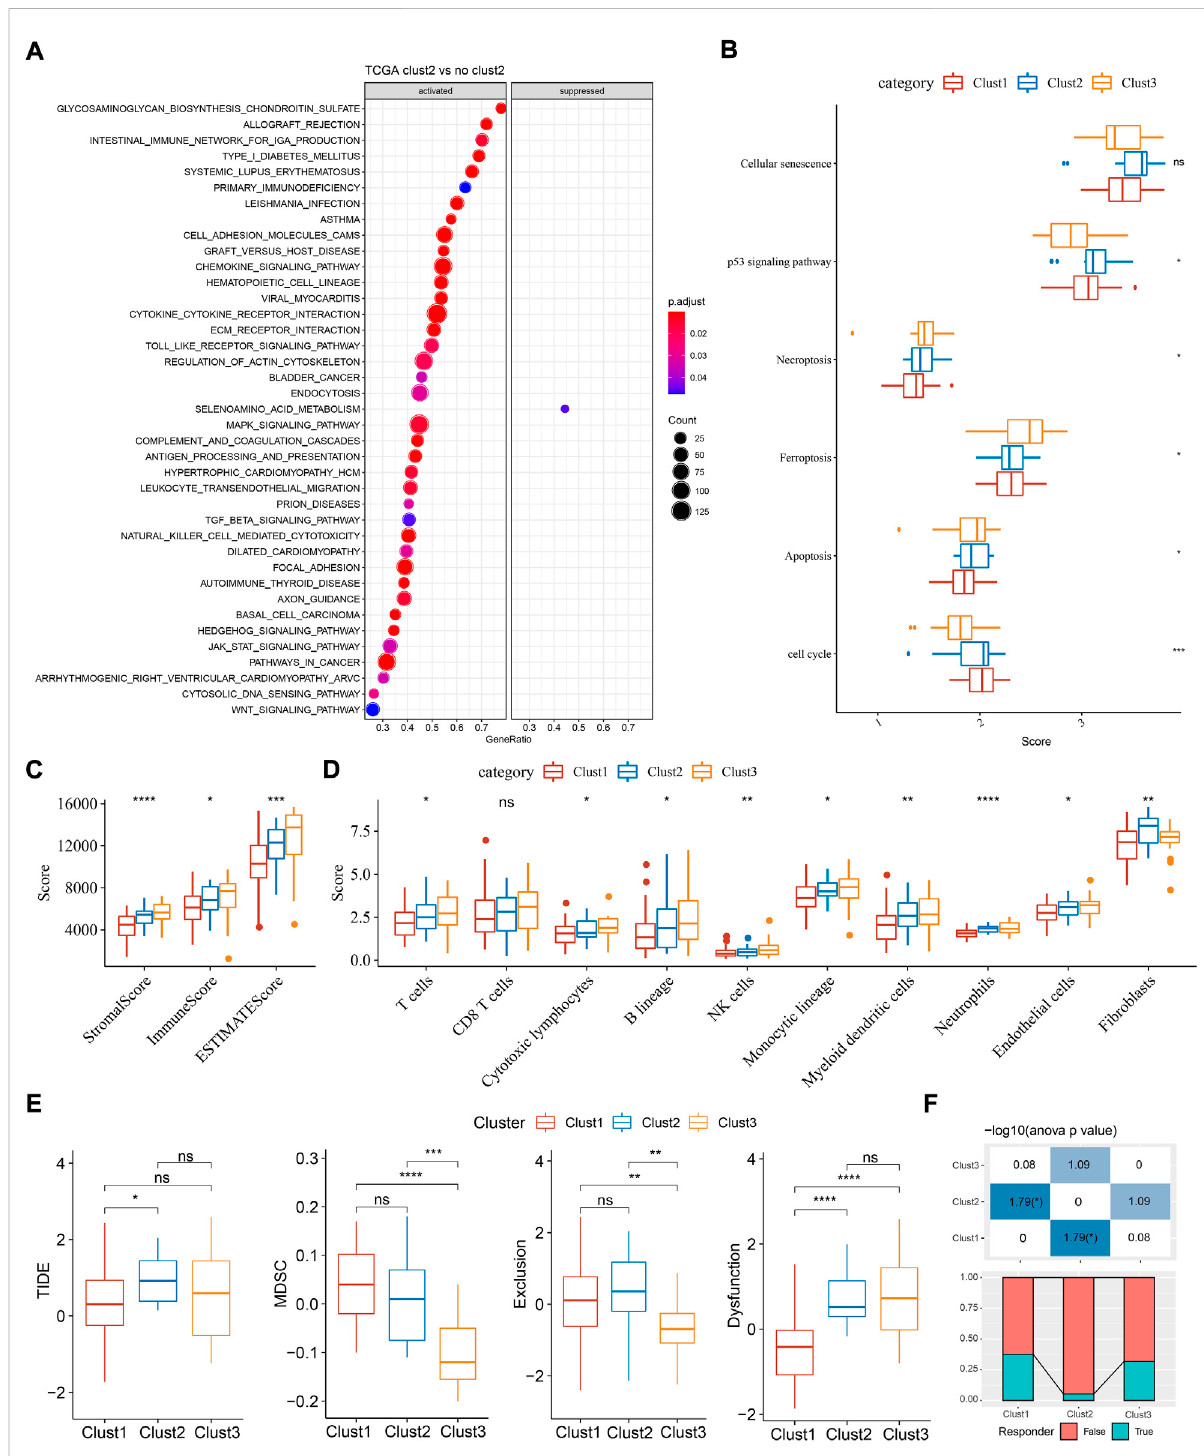
FIGURE 3 Functional analysis and immune analysis of three molecular subtypes in TCGA dataset. (A) GSEA result of clust2 vs non-clust2. (B) The ssGSEA score of six pathways related to cell death. (C) Stromal score and immune score calculated by ESTIMATE. (D) The estimated enrichment score of 10 immune cells. (E) TIDE analysis for predicting the sensitivity to immunotherapy. (F) The proportion of responders and non-responders in three subtypes. ANOVA was conducted. ns, not signi fi cant. * p < 0.05, ** p < 0.01, *** p < 0.001, **** p <